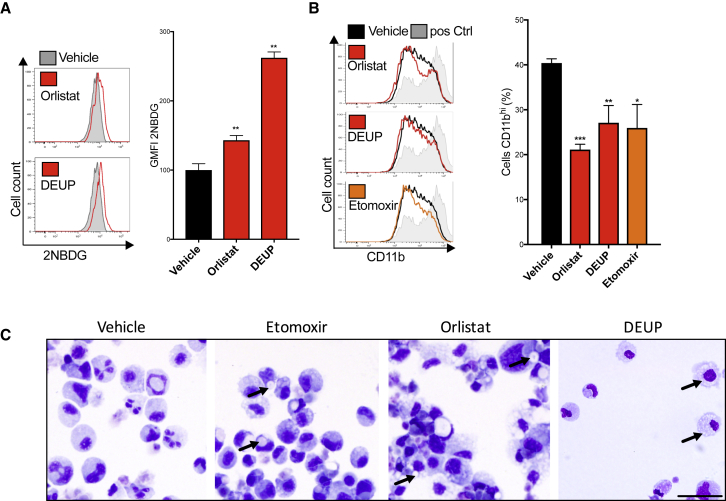
Lysosomal Lipolysis and FAO Are Required for Neutrophil Metabolic Switch and DifferentiationWild-type myeloblasts were treated with LAL-inhibitor orlistat (100 μM), lipase inhibitor DEUP (5 μM), FAO-inhibitor etomoxir (60 μM), or vehicle control during 5 days of G-induced differentiation. Data representative of three experiments.(A) Histograms (left) and quantification (right) of fluorescent glucose (2NBDG) uptake as geometric MFI ± SEM from four replicates on day 5 of G-CSF treatment.∗p < 0.05, ∗∗∗p < 0.01.(B) Histograms (left) and quantification (right) of CD11b maturation marker expression on day 5 of G-CSF-induced differentiation. Ctrl in gray are mature control cells (G-CSF day 7). Quantification shown as mean (±SD) percent of cells CD11bhi from four biological replicates, representative of three independent experiments.(C) Wright-Giemsa-stained cytospins after inhibitor treatment over 5 days of G-CSF-induced differentiation. Arrows indicate lipid droplets; scale bar, 50 μm.See also Figure S6.